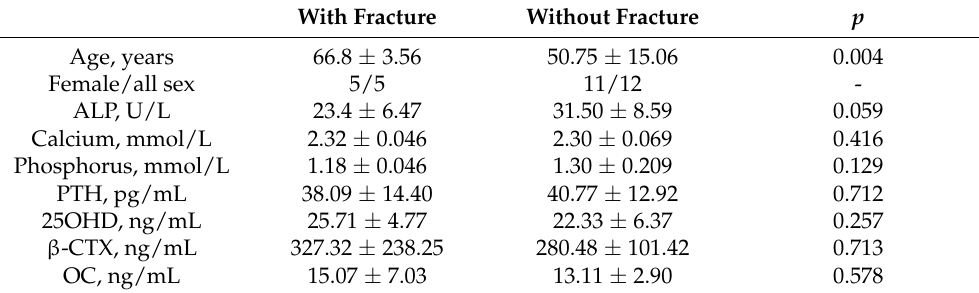
Table 3. Laboratory differences between monoallelic heterozygous patients with and without fracture. With Fracture Without Fracture p Age, years 66.8 ± 3.56 50.75 ± 15.06 0.004 5/5 11/12